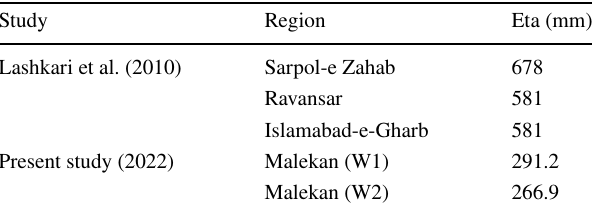
Table 6 Comparison of calculated wheat evapotranspiration values with different regions of Iran